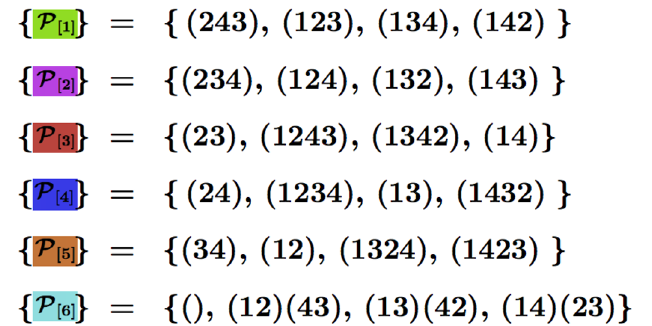
Figure 4 . A dissection of BC 4 in lexicographical ordering using “() 00 basis